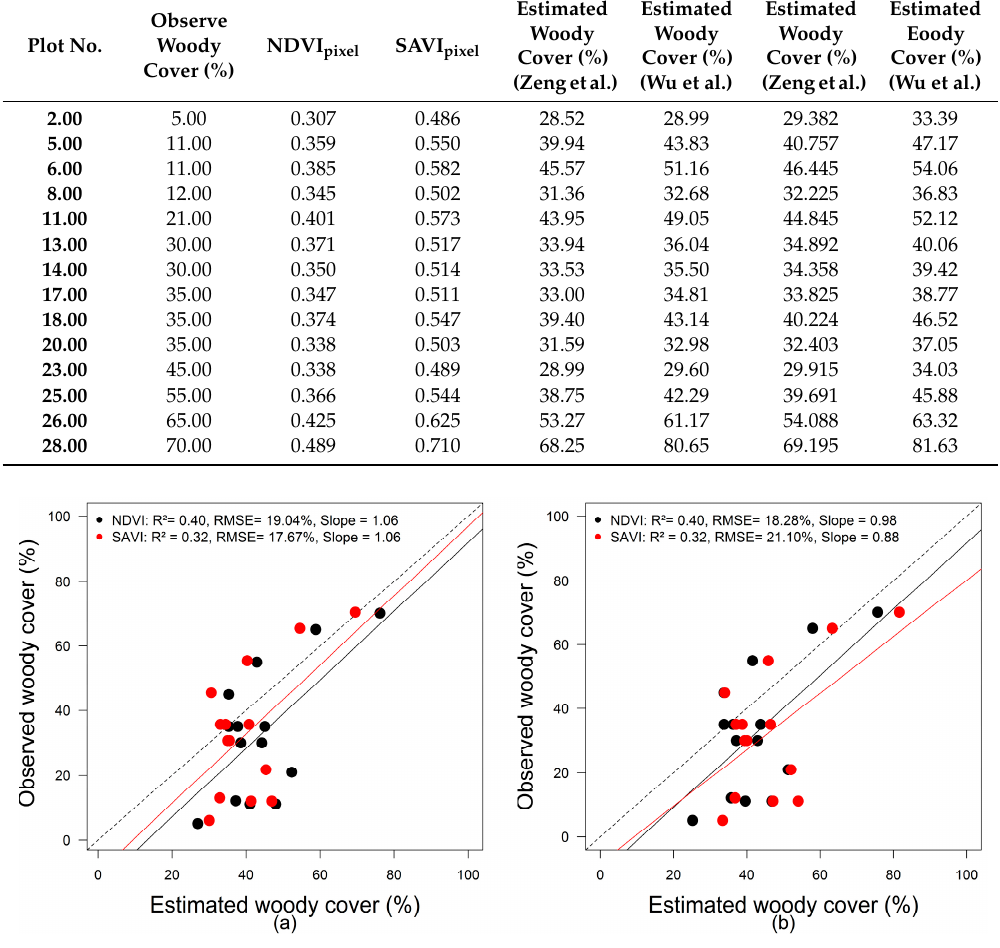
Table 4. Validation of MODIS NDVI woody cover maps estimated using two methods of soil signal removal.